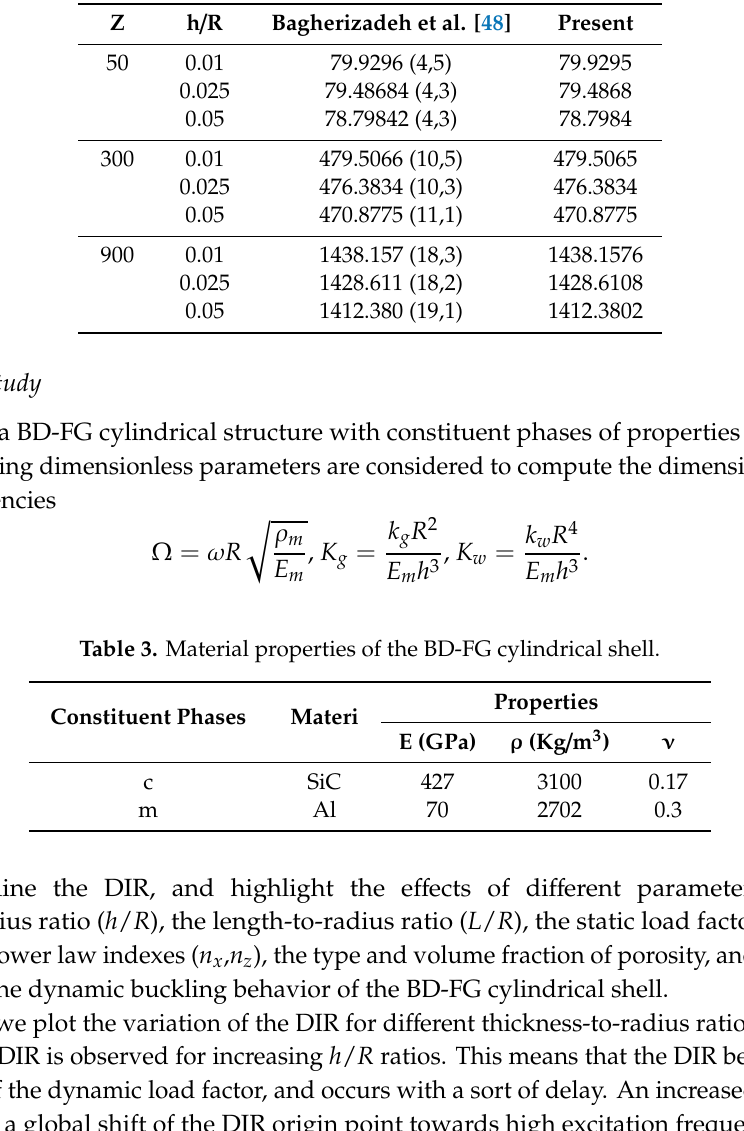
Table 2. Comparative evaluation of the dimensionless critical axial buckling load for a FG cylindrical